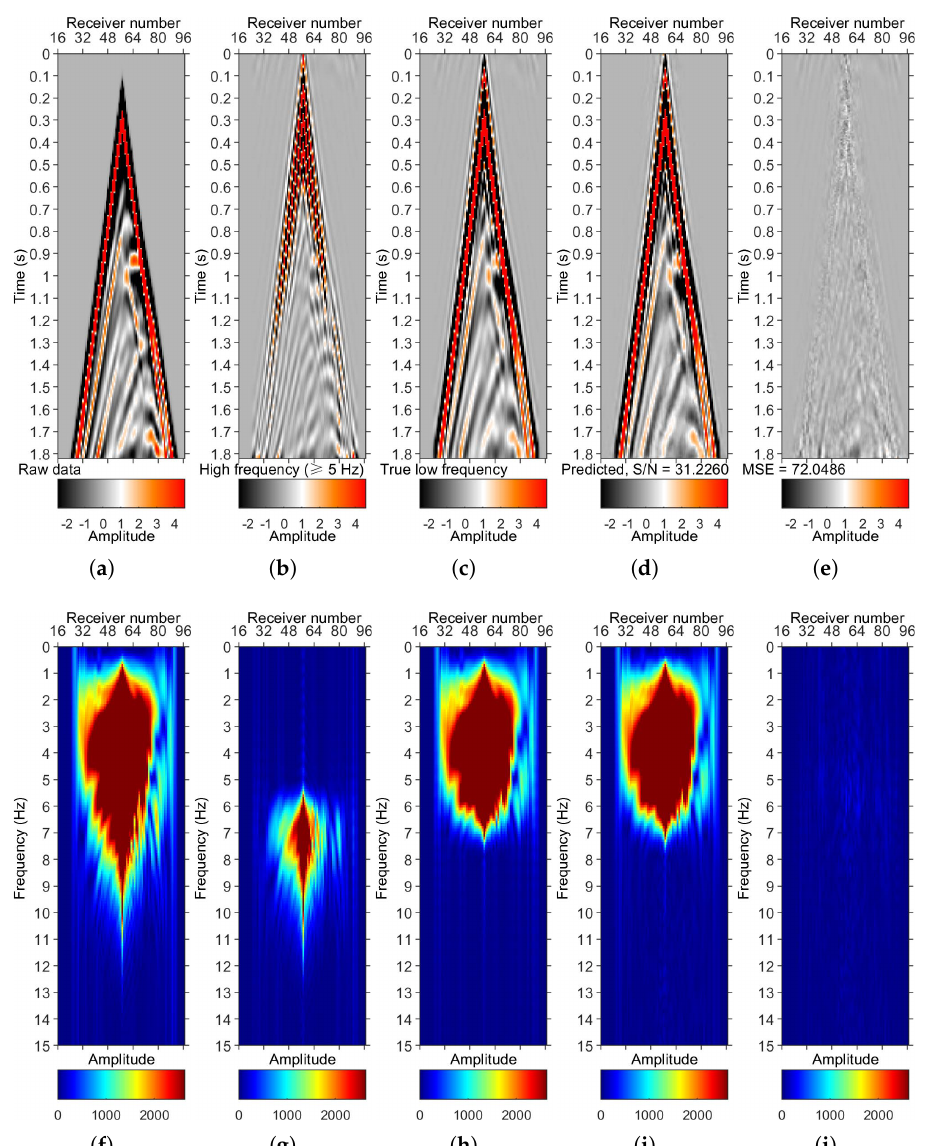
Figure 15. LFR on the Marmousi [39] synthetic dataset generated by PySIT (shot comparison). ( a ) A shot gather (shot number 49) of Figure 11a. ( b ) High-frequencies ( (cid:62) 5 Hz) of ( a ). ( c ) Low- frequencies of ( a ). ( d ) Predicted low-frequencies by the proposed method. ( e ) Difference between ( c , d ), i.e., ( e ) = ( c )-( d ). Panels ( f – j ) correspondingly show the amplitude spectra of the Fourier transformed data (along the time direction) of the data shown in panels ( a – e